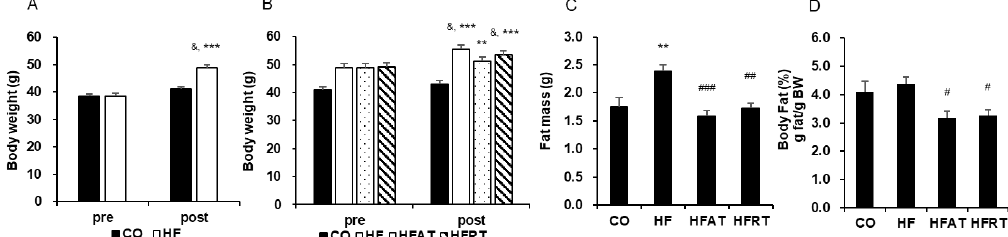
Figure 1. Changes in body weight and body fat after obesity induction and exercise intervention.